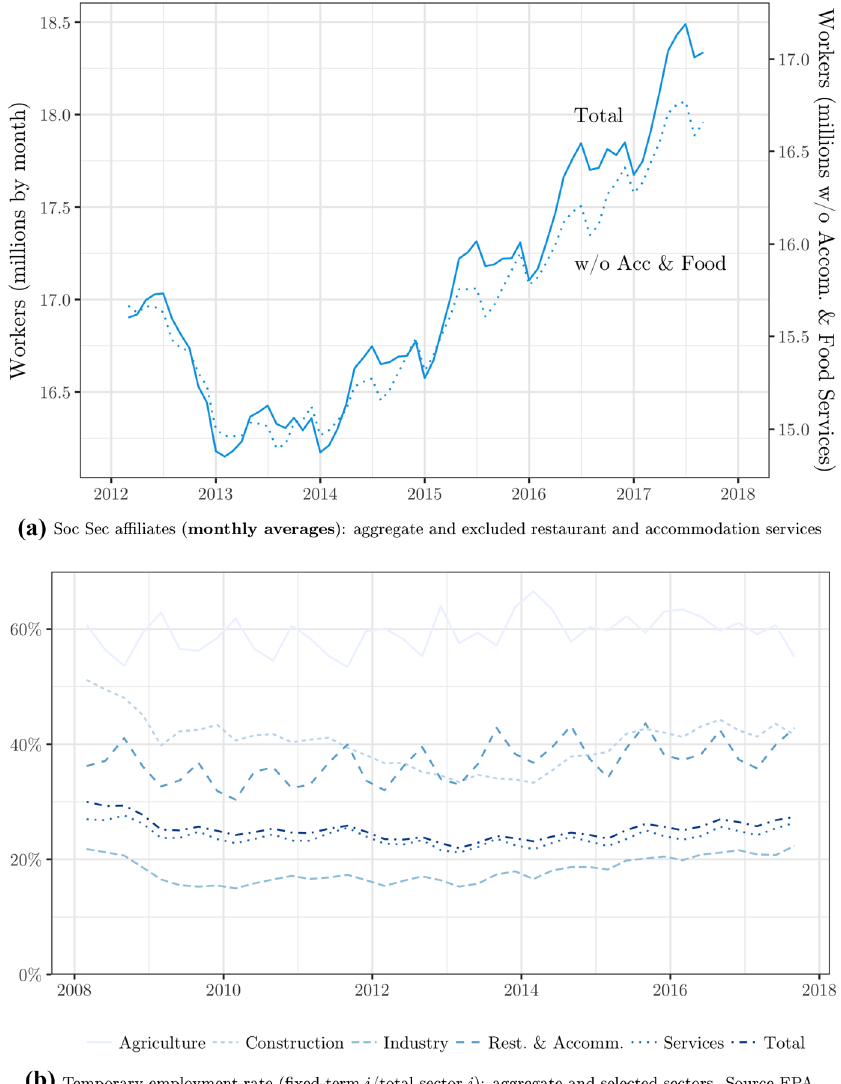
Fig. 2 Employment measures in various sectoral activities about the issue of the sectoral composition of the economy and its interaction with the share of temporary workers in some specific